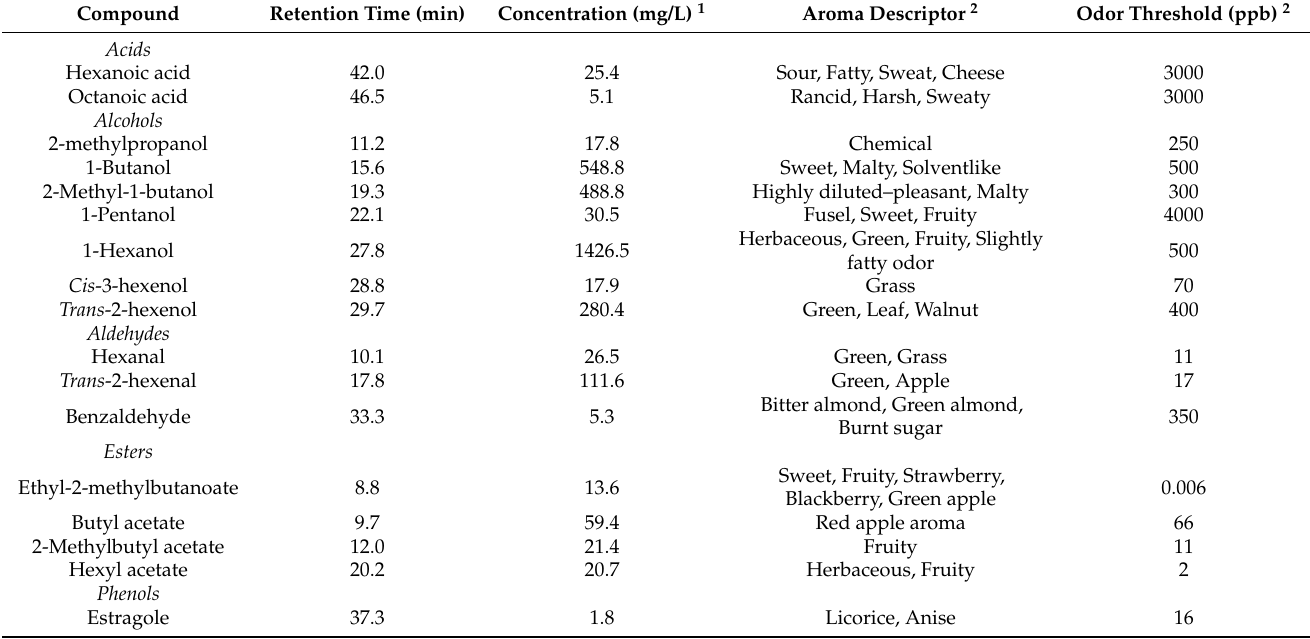
Table 2. SDE/GC–qMS volatile compound quantification of apple aroma stored at room temperature, aroma descriptors, and odor threshold reported in